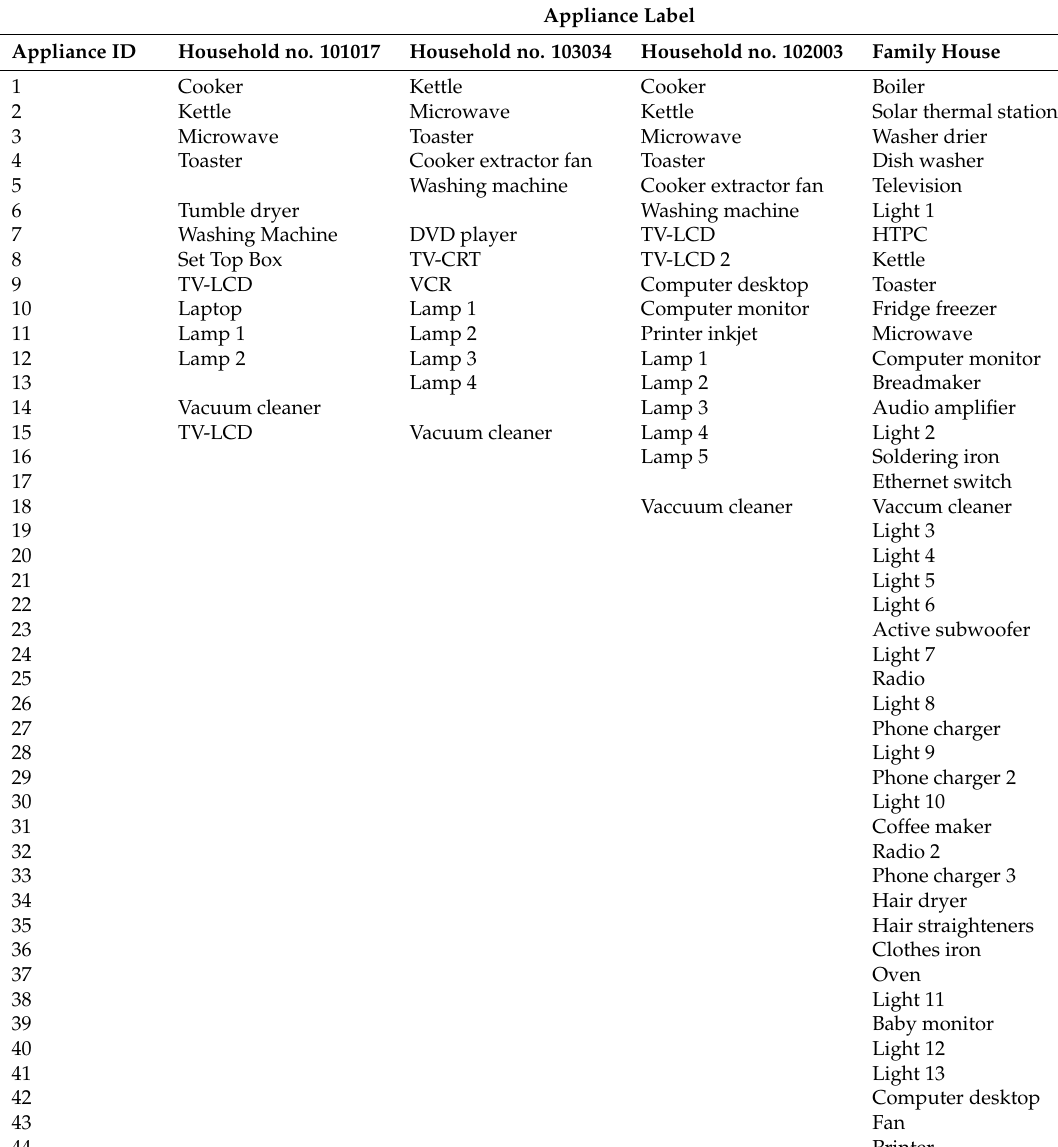
Table 4. Appliance labelling in the y -axis by